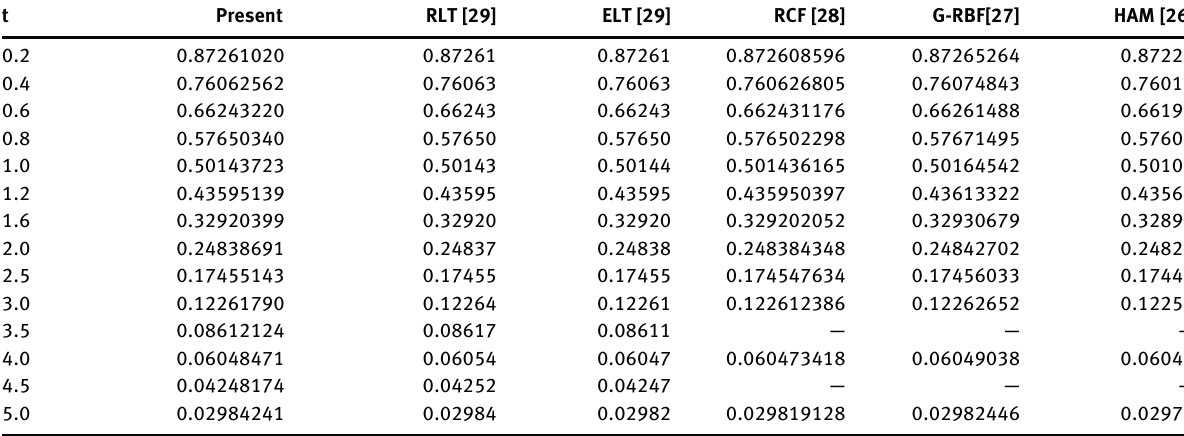
Table 7: Comparison of the obtained values of y ( t ) for various values of t by the present method, RLT, ELT, RCF, G-RBF, and HAM t